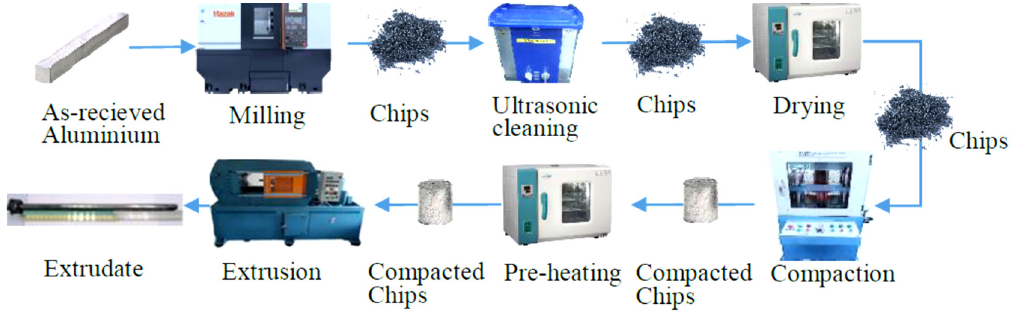
Figure 3. Extrusion procedure in recycling aluminium chips.